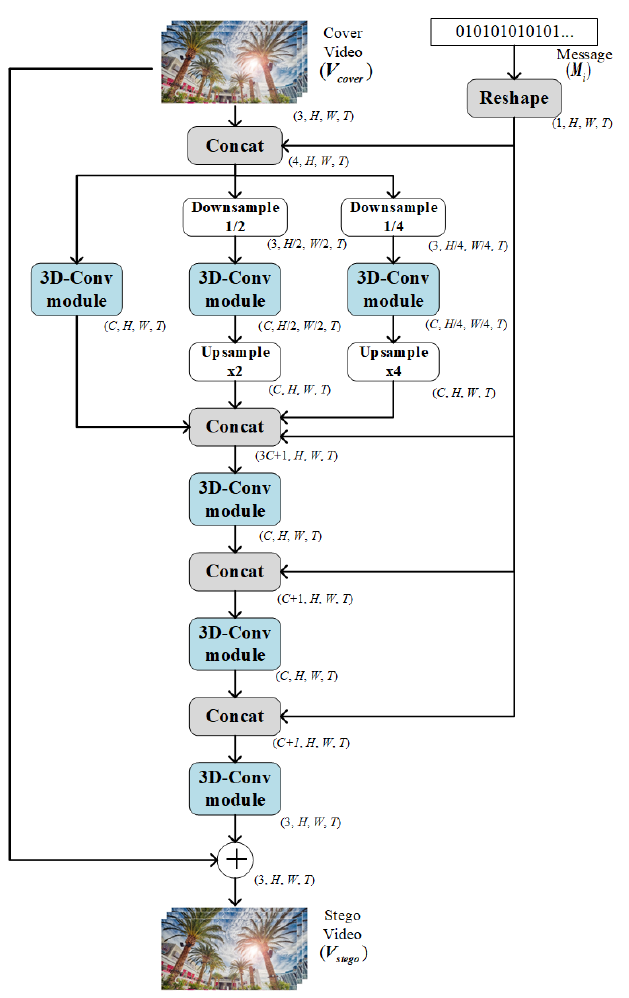
Figure 2. The network design of encoder.